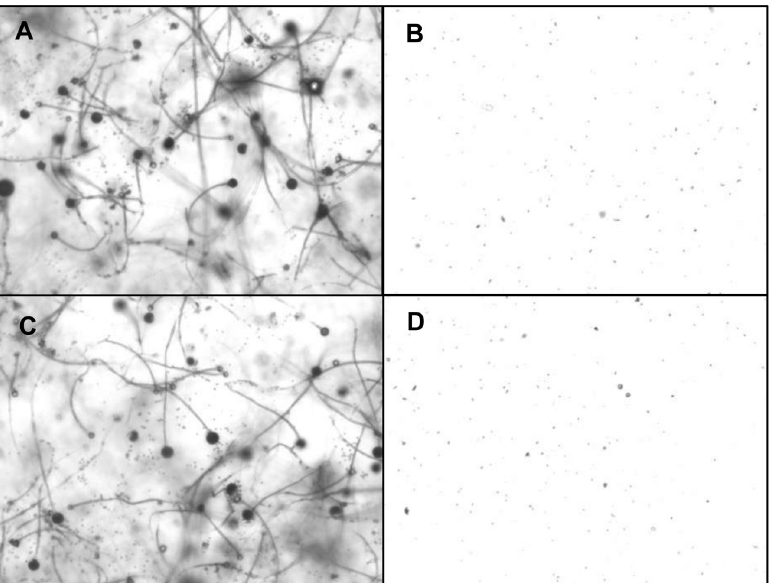
Fig 9. Mycelial inhibition of Rhizopus sp. and Mucor sp. using HPLC eluted 3-phenyllactic acid under EVOS live cell imaging microscopy resulted in minimum inhibitory concentration (180 mg/ml). (A) Rhizopus sp. (untreated), (B) Rhizopus sp. treated with PLA, (C) Mucor sp. (untreated), (D) Mucor sp. treated with PLA.